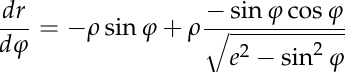
where r is the polar radius, mm; ρ is the distance between O and O 1 , mm; ϕ is the angle between the polar radius of any point on the circle and the x -axis; R is the radius of the eccentric circle, mm. The derivative function of Equation (1) was